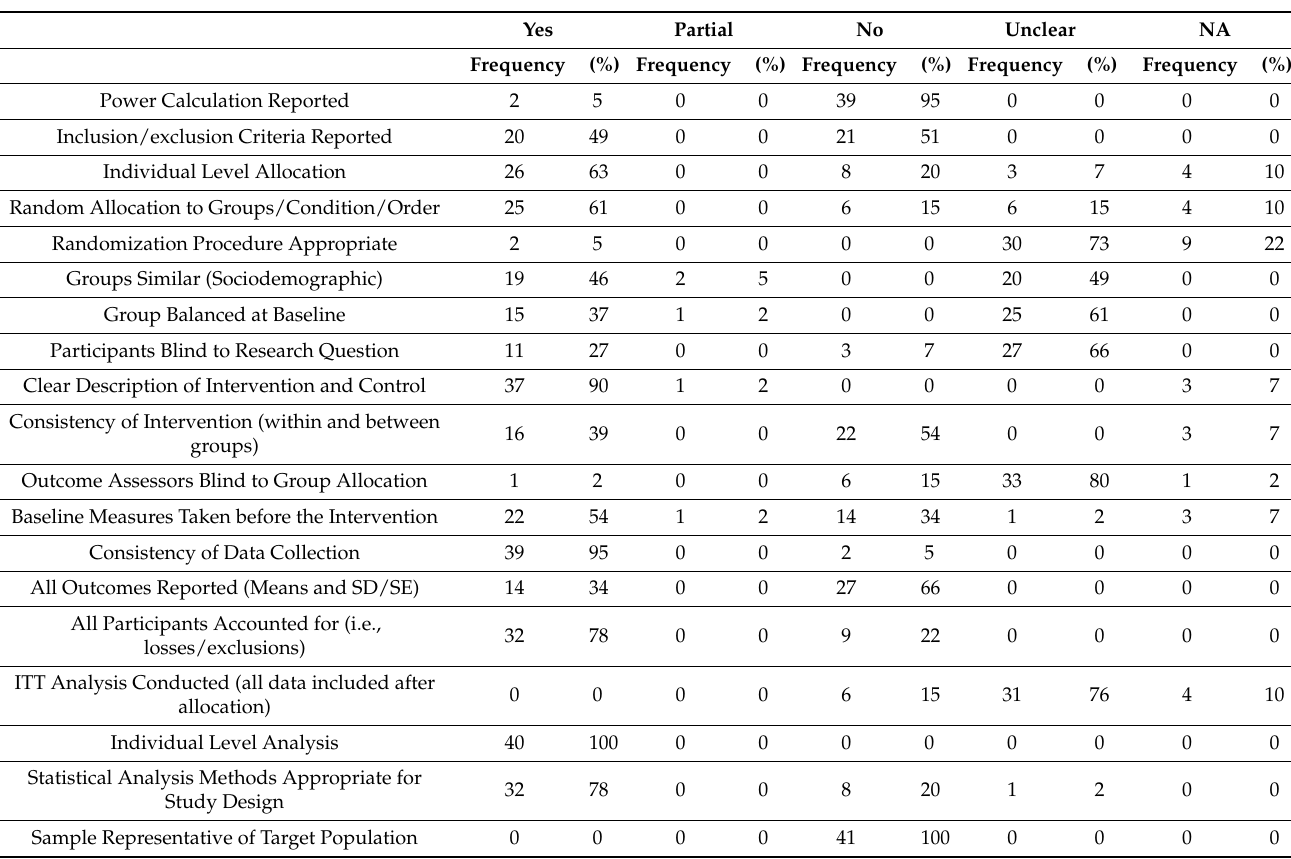
Table 6. Statistics of quality appraisal of records in this